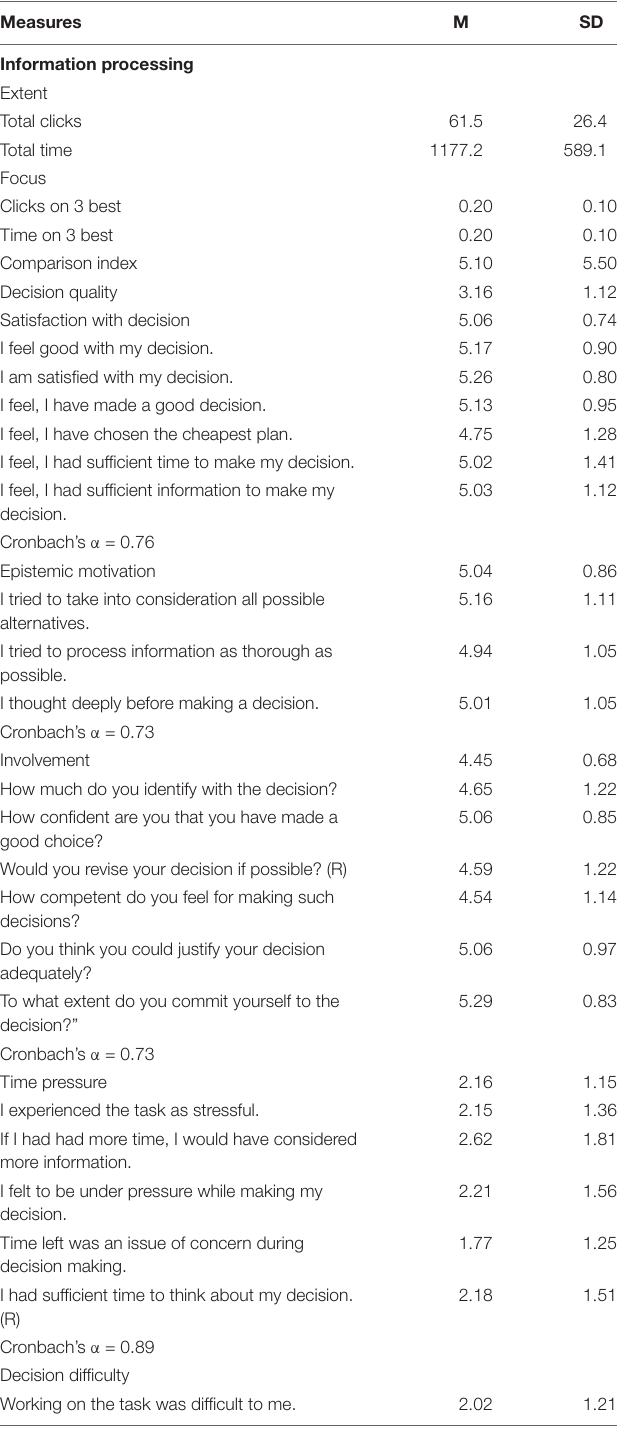
TABLE 1 | Variables and Summary